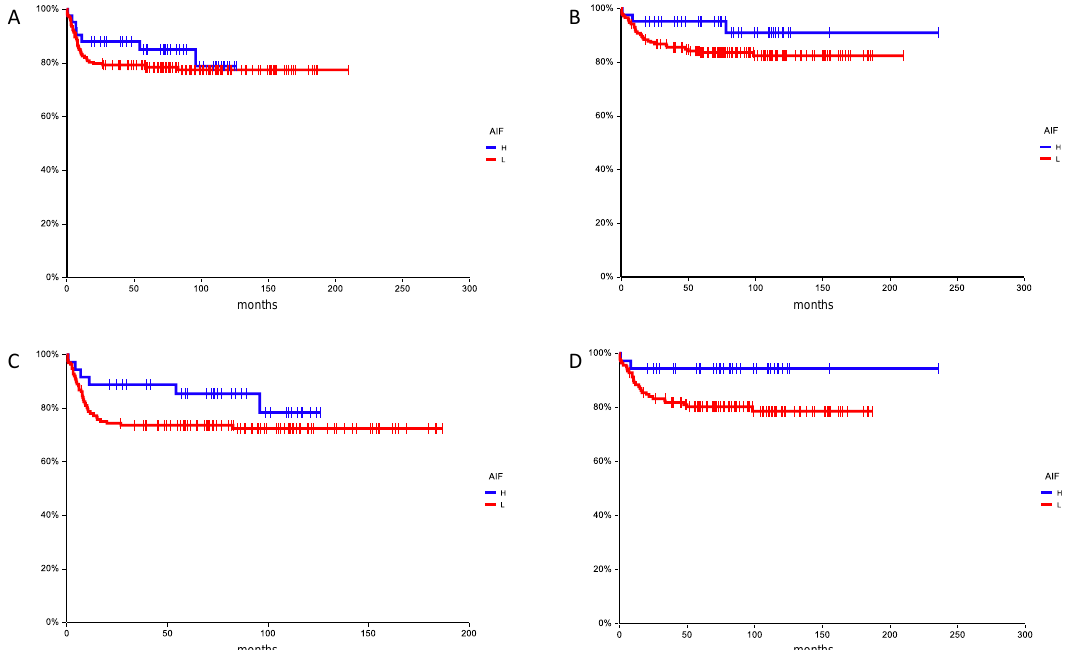
Figure 8. ( A ) Kaplan–Meier estimates of probabilities of progression-free survival according to AIF expression in testicular germ cell tumor patients ( n = 216), HR = 0.74, 95% CI 0.35–1.53, p = 0.46; H—high AIF (QS ≥ 10); L—low AIF (QS < 10). ( B ) Kaplan–Meier estimates of probabilities of overall survival according to AIF expression in testicular germ cell tumor patients ( n = 216), HR = 0.42, 95% CI 0.18–1.00, p = 0.14; H—high AIF (QS ≥ 10); L—low AIF (QS < 10). ( C ) Kaplan–Meier estimates of probabilities of progression-free survival according to AIF expression in metastatic testicular germ cell tumor patients (stage IS to III.C) ( n = 173), HR = 0.57, 95% CI 0.28–1.18, p = 0.20; H—high AIF (QS ≥ 10); L—low AIF (QS < 10). ( D ) Kaplan–Meier estimates of probabilities of overall survival according to AIF expression in metastatic testicular germ cell tumor patients (stage IS to III.C) ( n = 173), HR = 0.26, 95% CI 0.11–0.62, p = 0.048; H—high AIF (QS ≥ 10); L—low AIF (QS <